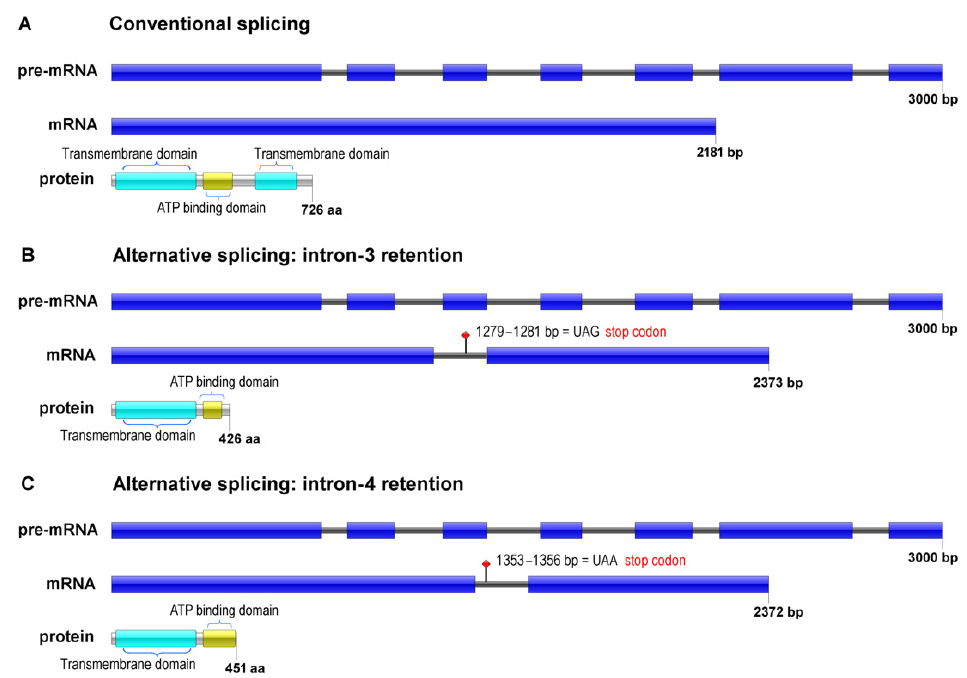
Figure 1. Schematic representation of Intron retention in TERG_04309 of Trichophyton rubrum , showing pre-mRNA, mRNA, and proteins resulting from conventional splicing ( A ) and alternative splicing promoted by Intron-3 retention ( B ) or intron-4 retention ( C ). Exons are shown as colored boxes; introns are shown as solid lines. Premature stop codons are indicated. Conserved sites and domains are indicated in the structure of the proteins.